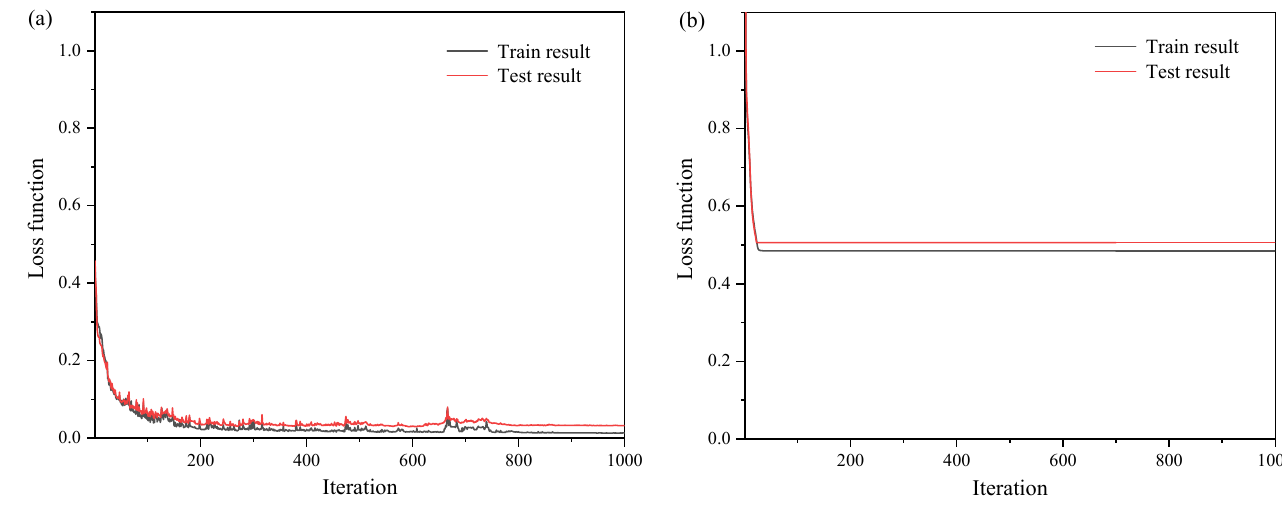
Figure 5. The loss function of the neural network: ( a ) the forward simulation model; ( b ) the backward design model.